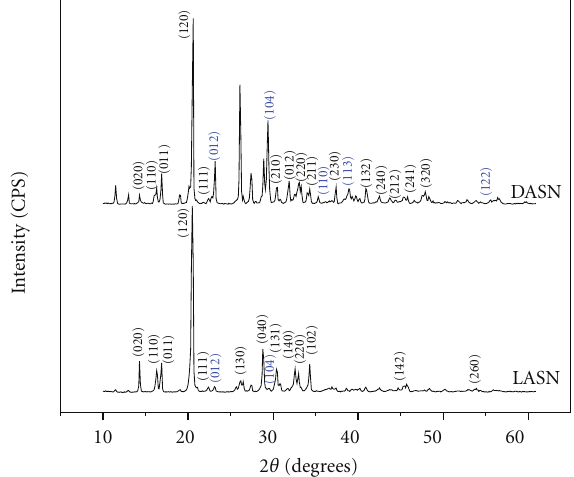
Figure 1: Powder X-ray di ff ractogram of L-alanine sodium nitrate (LASN) and D-alanine sodium nitrate